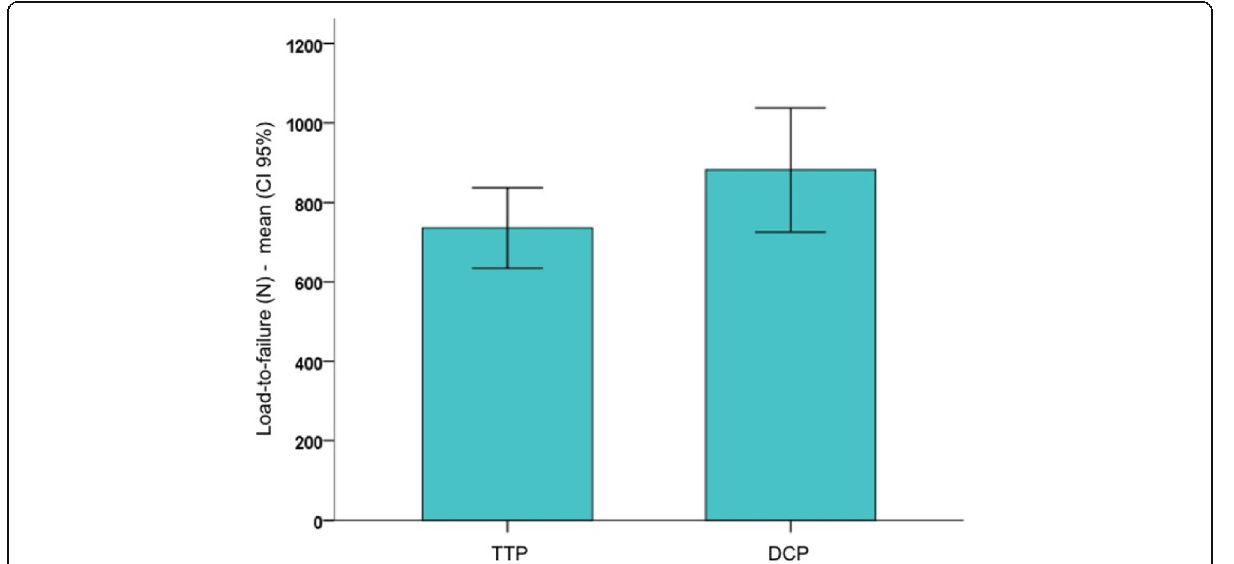
Fig. 6 Load-to-failure for the TTP and DCP experimental groups (mean and CI 95%)